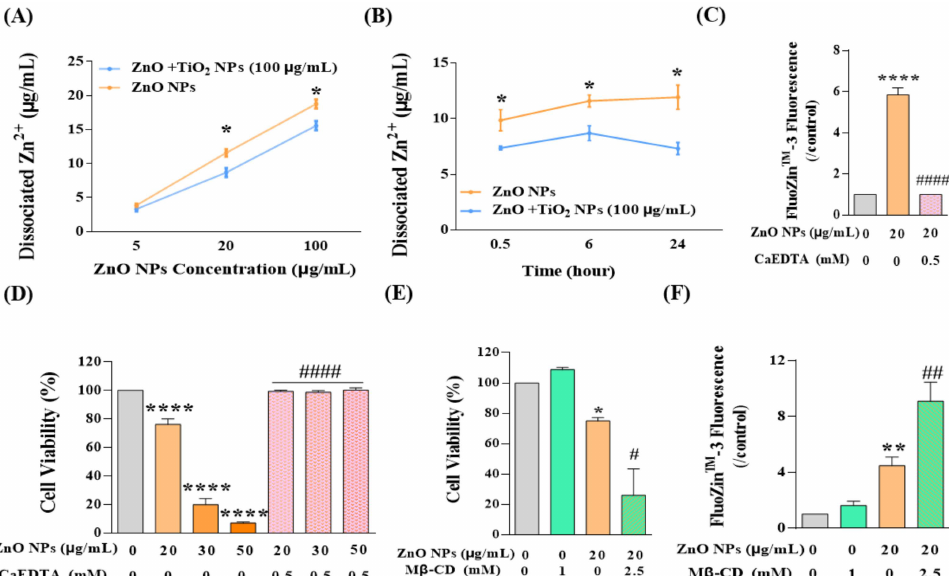
Figure 7. TiO 2 NPs decreased the dissociation of ZnO NPs, thus reducing the content of the main toxic contributor Zn 2+ . ( A , B ) The dissociated Zn 2+ of ZnO NPs at ( A ) different concentration (5, 20, 100 µ g/mL) and ( B ) different time intervals (0.5, 6, 24 h) was detected by AAS. ( C – F ) Cy- totoxicity and intracellular Zn 2+ ions were detected after the treatment of ZnO NPs with or without CaEDTA ( C , D ) and M β -CD ( E , F ). * p < 0.05, ** p < 0.01, **** p < 0.0001 compared to the co-exposure group or the control group. # p < 0.05, ## p < 0.01, #### p < 0.0001 compared to ZnO NP-treated